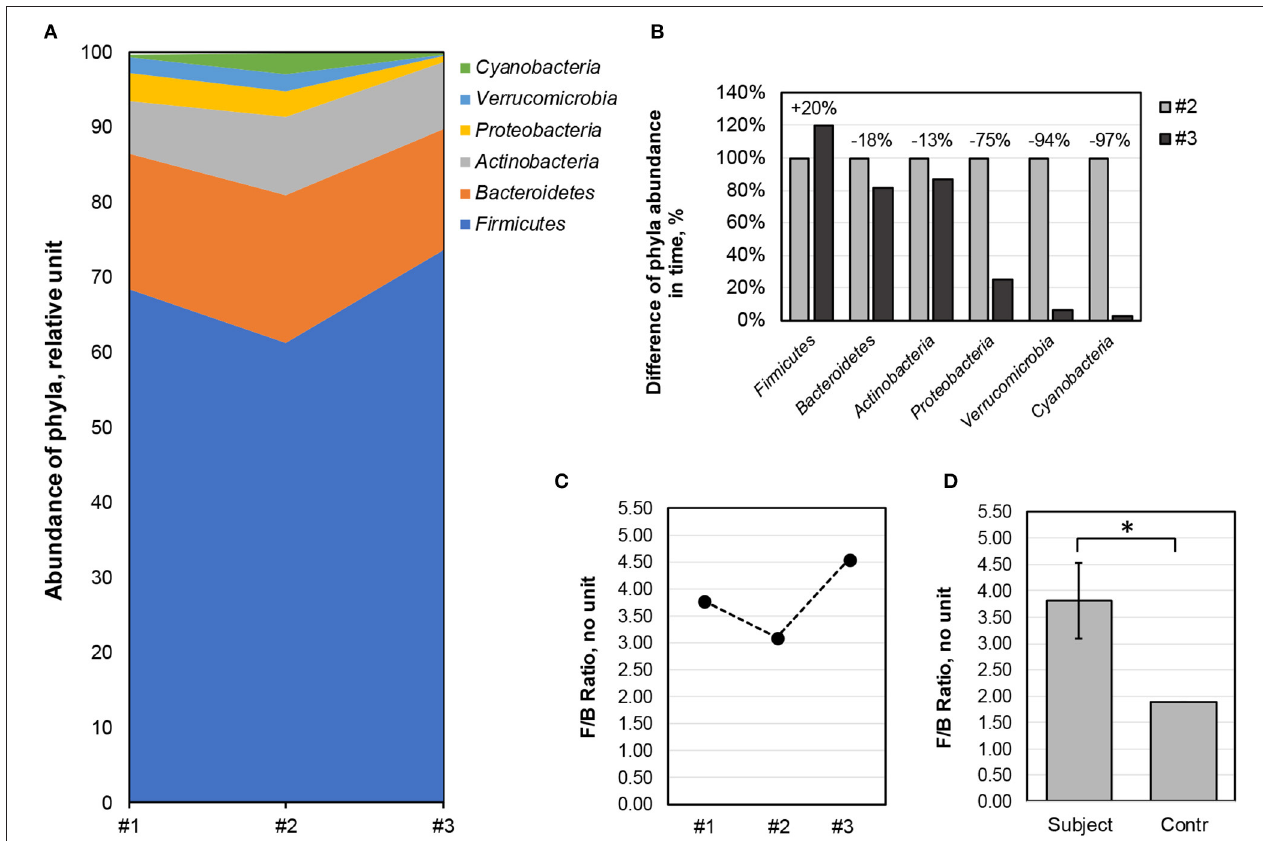
FIGURE 3 | Dynamic changes in bacterial phyla composition over the study period. (A) Changes in the abundance of the six most numerous phyla ( Firmicutes , Bacteroidetes , Actinobacteria , Proteobacteria , Verrucomicrobia , and Cyanobacteria ) in three serial samples ( x -axis). y -axis—abundance of phyla, in relative units. (B) Proportional changes in the abundance of the six major phyla upon fiber consumption. The abundance of each phylum in sample #2 was equated to 100%, and the change in sample #3 relative to sample #2 is indicated above the columns. y -axis—relative abundance (%) of phylum in samples #2 and #3; x -axis—phyla. (C) Changes in F / B ratio over the 31-week study period, measured at three serial time points ( x -axis). y -axis— F / B ratio. (D) The young athlete showed a high F / B ratio as compared with the control group (single mean t -test, p -value < 0.05, denoted by *). The bar graph represents the arithmetic mean of the F / B ratio in study samples and the error bars represent the standard deviation. y -axis— F / B ratio. #1, time point week 1 (baseline); #2, time point week 27 (high training and competition period); #3, time point week 31 (after 30 days of dietary supplement